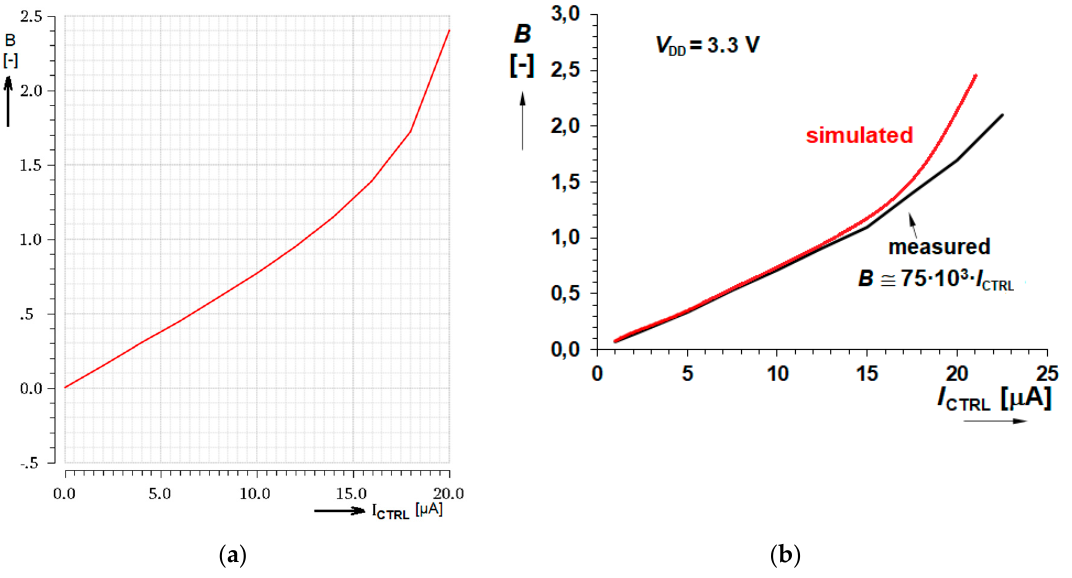
Figure 9. Gain control characteristics ( a ) Typical Cadence simulation of the gain controlled by current I CTRL ; ( b ) Simulation and measurement comparison.